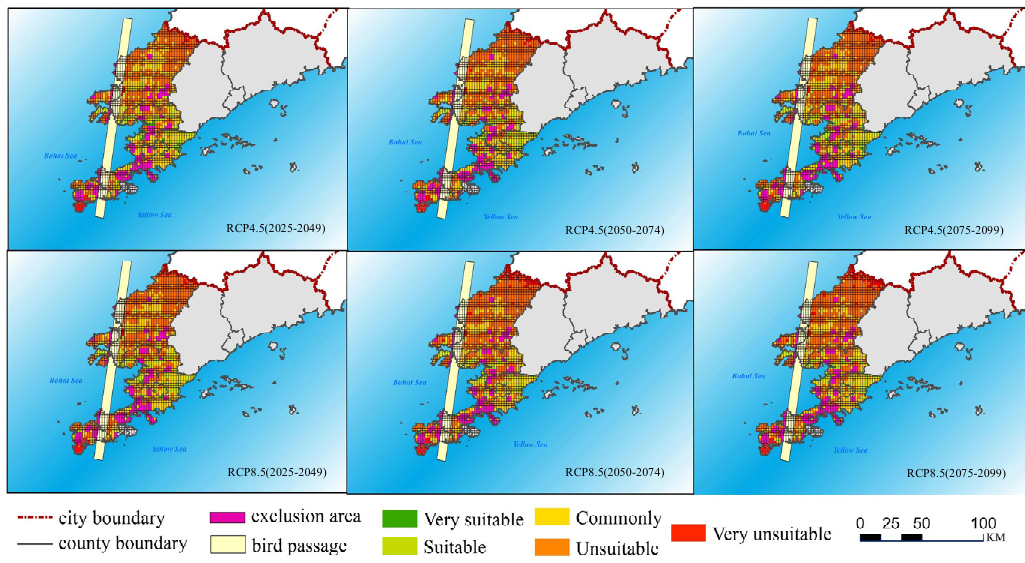
Figure 5. Evaluation results under two climate change scenarios.